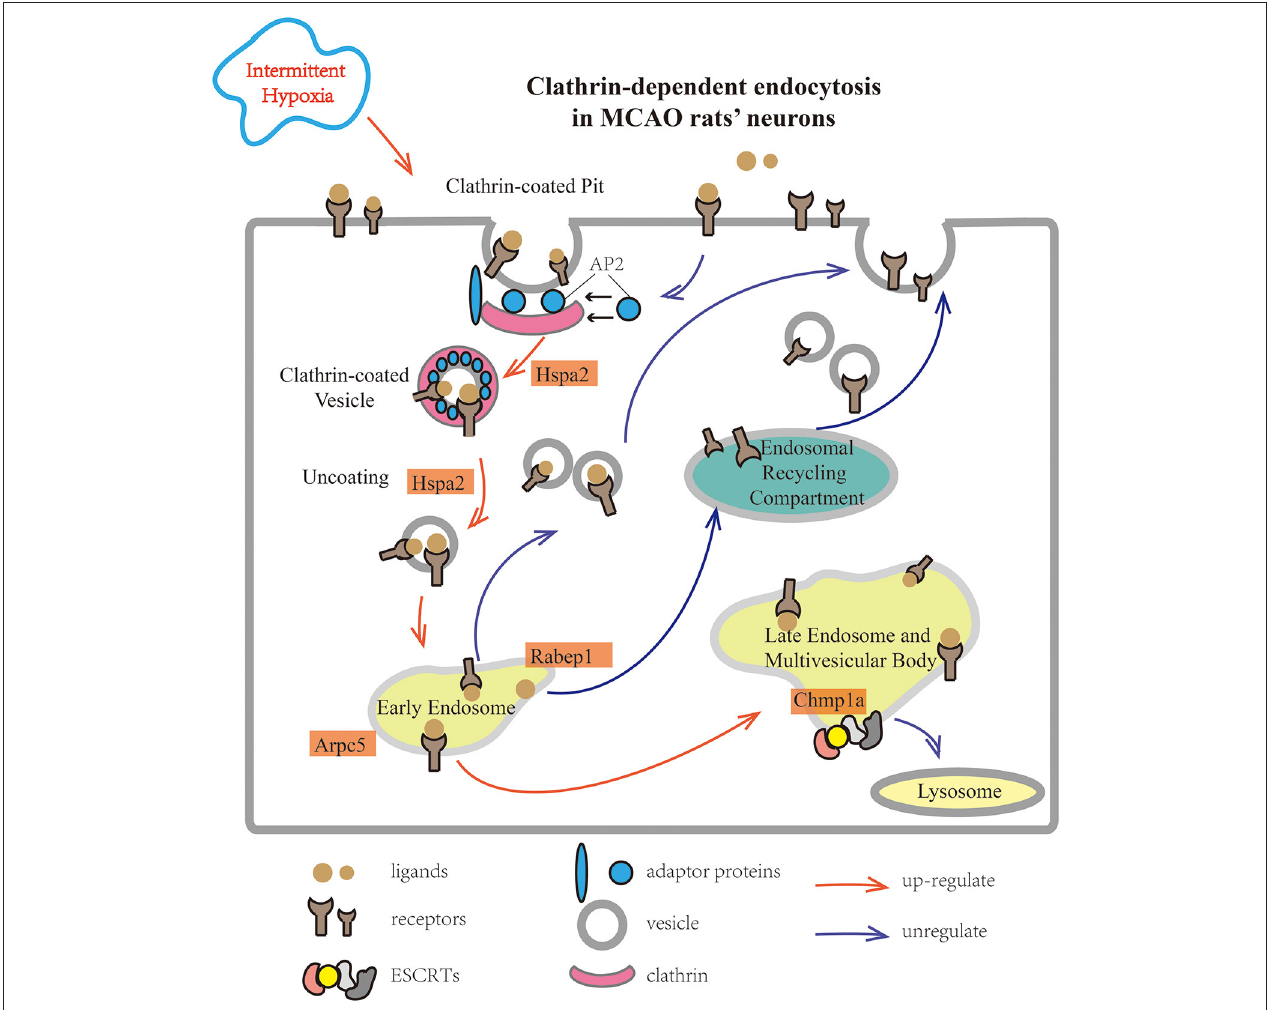
FIGURE 9 | The main biological process changed in preconditioned MCAO rats’ cortex based on KEGG pathways. After combining clathrin and adaptor proteins on the cytoplasmic side of the cell membrane, the signal receptors were collected on the surface of the cell membrane into clathrin-coated pits. Next, the pits were invaginated and pinched off the clathrin-surrounded membrane, the uncoated vesicle fused with the early endosome using Hspa2. This process included two factors, Arpc5 and Rabep1, which were up-regulated in the intermittent hypobaric hypoxia preconditioned group. In the case of CDE, the main outcomes were: (1) return to the cell membrane through the endosomal recycling compartment, and (2) entry into late endosomes and multivesicular bodies, and degradation by the lysosomal pathway. ESCRTs play a pivotal role during this process, and Chmp1a is essential for its function. KEGG, Kyoto Encyclopedia of Genes and Genomes; MCAO, middle cerebral artery